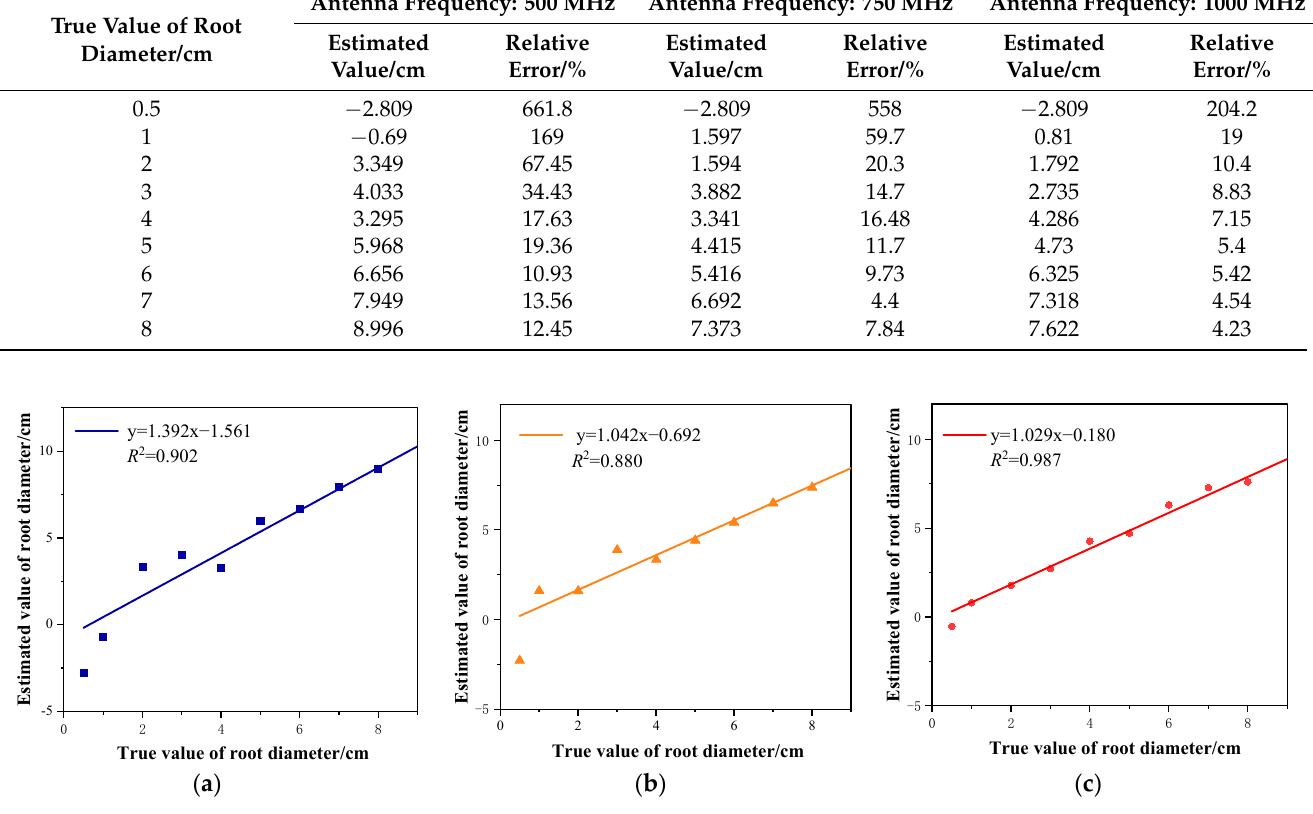
Table 2. Root diameter estimation results.